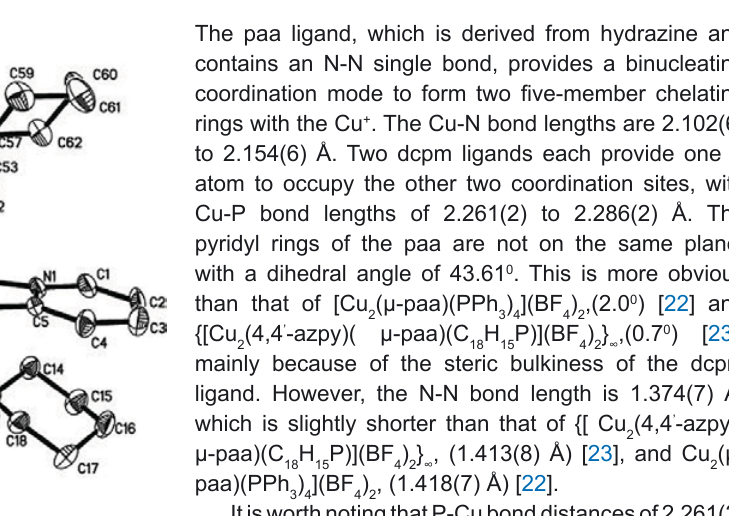
Cl (solid line) and CH 2 2